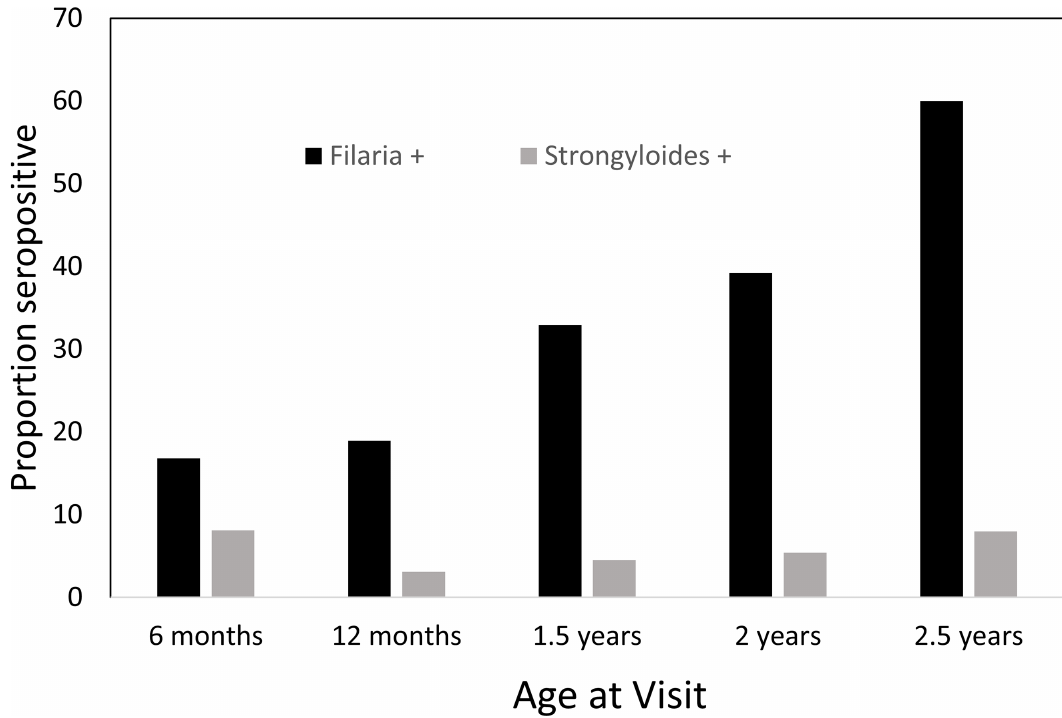
Fig 3. Proportions of children seropositive for filaria and for Strongyloides by age. The proportion of children with filarial antibodies increased with age: 16.8% at 6 months, 18.9% at one year, 32.9% at 1.5 years, 39.2% at 2 years to 60.0% at 2.5 years. In contrast, the proportion of children with antibodies to Strongyloides stayed fairly constant: 8.1% at 6 months, 3.1% at 1 year, 4.5% at 1.5 years, 5.4% at 2 years and 8.0% at 2.5 years.